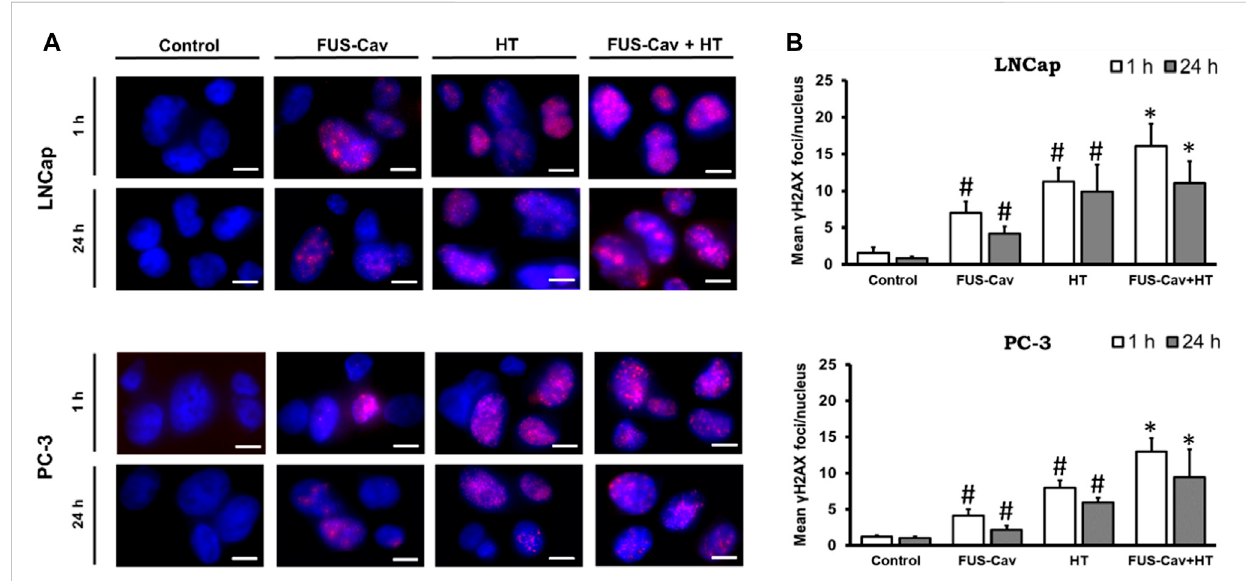
FIGURE 4 DSBs increased when FUS and HT were combined as opposed to when they were administered separately. (A) H2A.X foci (Alexa fl our568 red) in the cell nucleus (blue) after single FUS or single HT is shown in representative microscopic fl uorescence images, with the combined treatment (FUS + HT) displaying agreater amount of H2A.X foci than every single treatment. Scale bar = 10 µm. (B) Semi-quantitative analysis of H2A.X foci at 1- and 24- hours post-treatment.Datawerepresentedasmean±SEM, n =6,*signi fi cantlydifferentfromHT( p ≤ 0.05),#signi fi cantlydifferentfromcontrol( p ≤